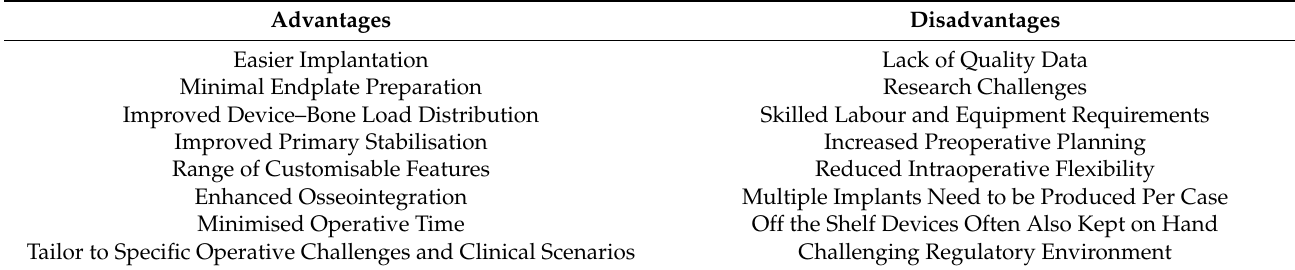
Table 1. Summary of the key advantages and disadvantages, including largely theoretical points, associated with patient- specific implant use by spinal